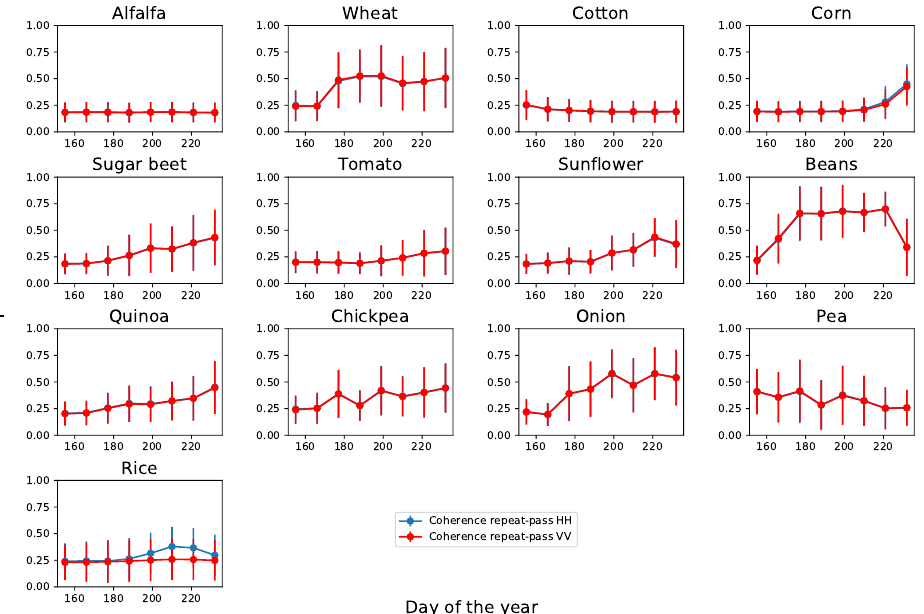
Figure 6. Temporal evolution of the repeat-pass interferometric coherence at HH (blue) and VV (red) channels for all crop types. Dots represent the average values and the error bars denote the standard deviation of the